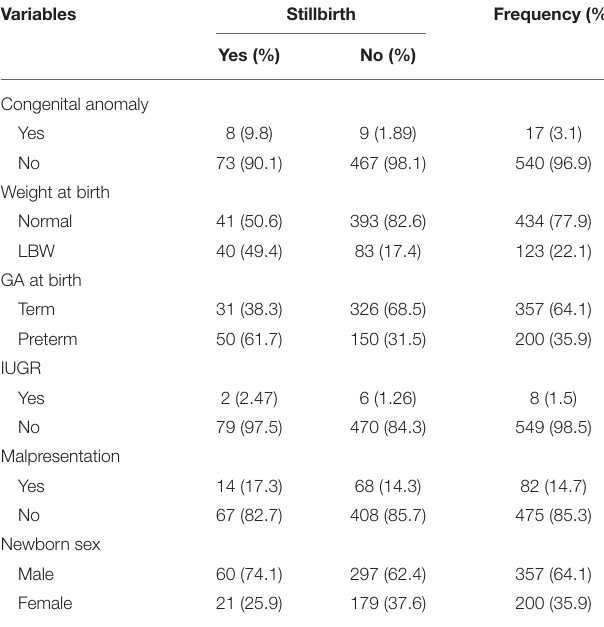
Prevalence of Stillbirth 17.6%) ( Figure 1